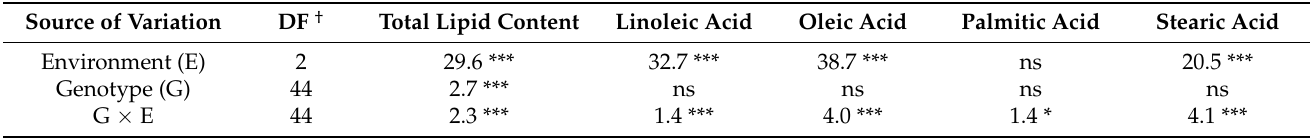
Table 2. F-values for the sources of variation (i.e., environments (E), genotype (G), and G × E interactions) from the mixed model for the total oil content and fatty acids in noug. Source of Variation DF † Total Lipid Content Linoleic Acid Oleic Acid Palmitic Acid Stearic Acid Environment (E)